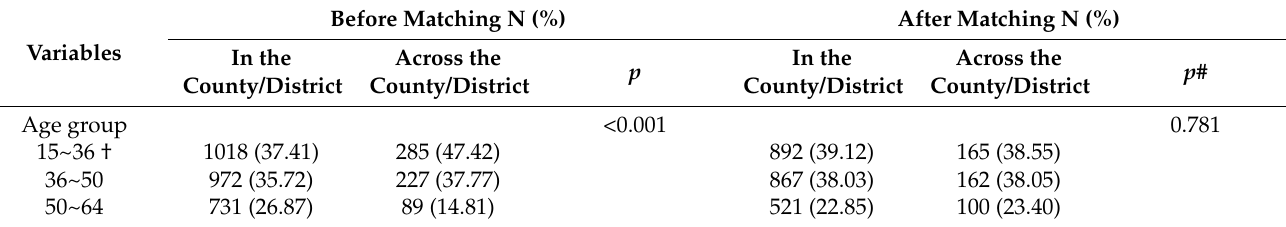
Table 2. Summary statistics for key variables after coarsened exact matching. Before Matching N (%) After Matching N (%) In